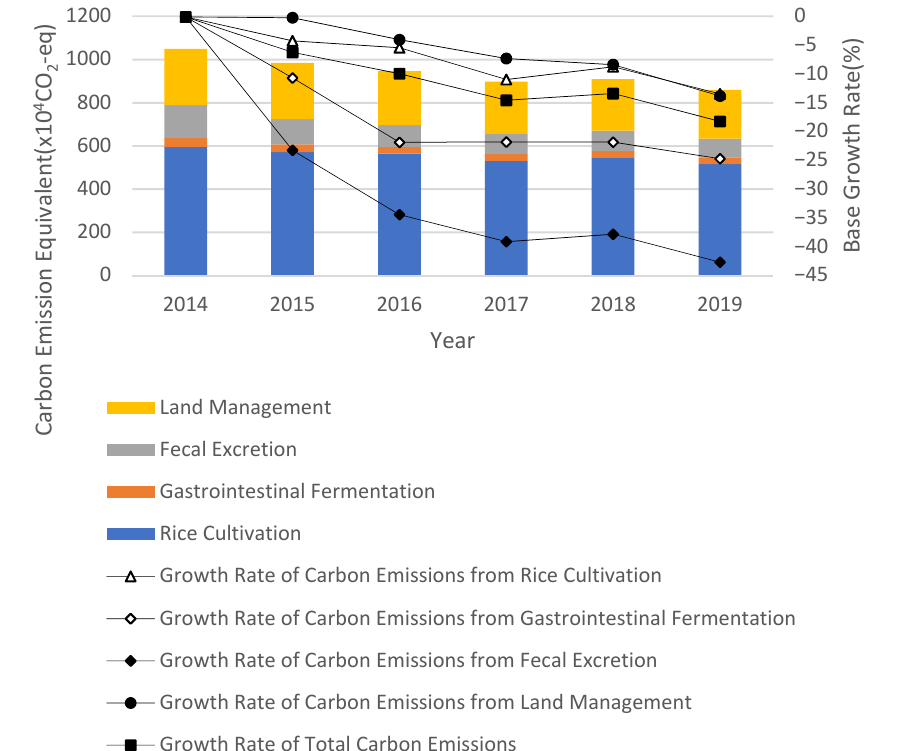
Figure 3. Change Trend of Agricultural Greenhouse Gas Emissions in Zhejiang Province from 2014 to 2019.